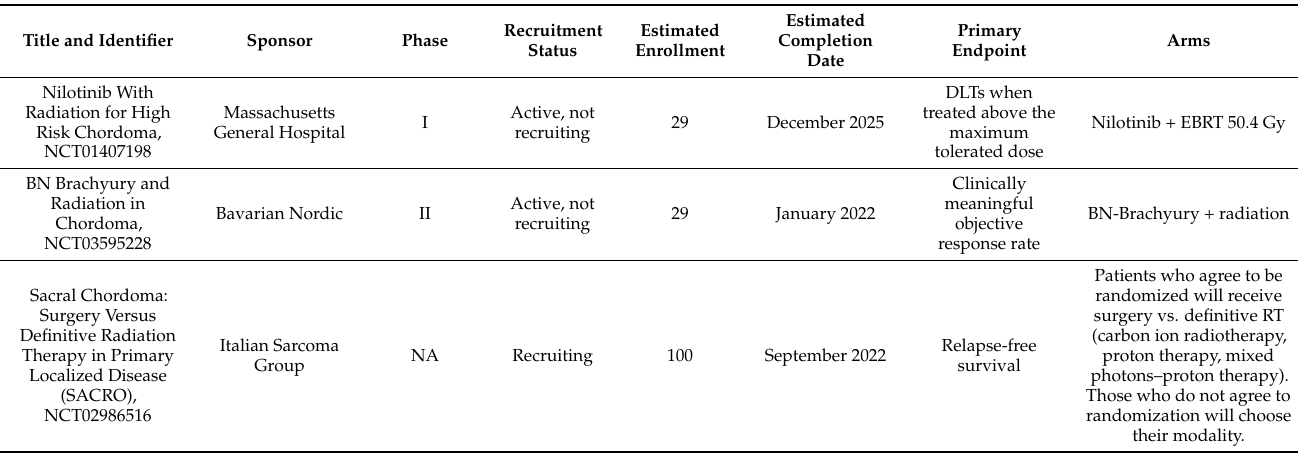
Table 6. Ongoing and completed but not published clinical